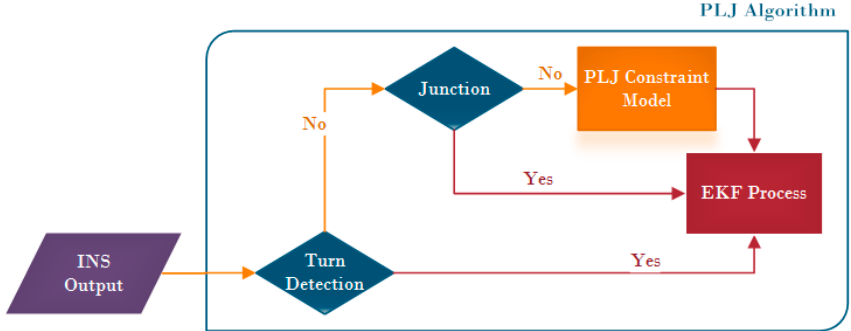
Figure 9. Algorithm for corrected state estimation.